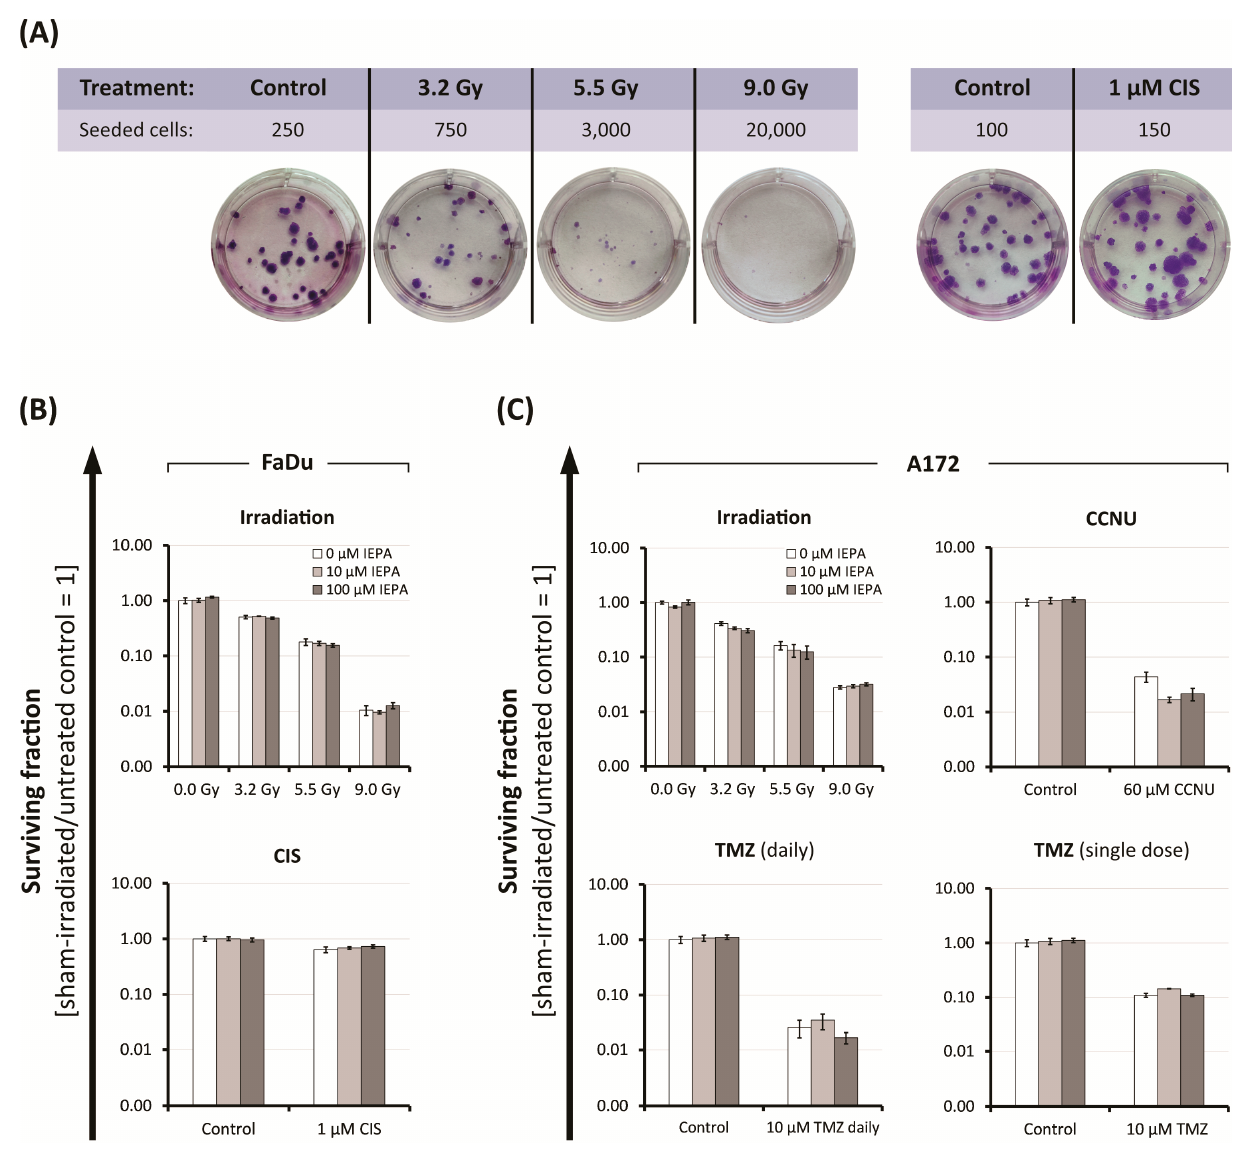
Figure 4. ( A ) Representative images of FaDu colonies, grown in a 6-well plate for clonogenic assay after IR and CIS treatment, stained with Giemsa. Colonies were scored 14-16 days after start of treatment. Clonogenic survival after treatment with IEPA of ( B ) FaDu cells irradiated or treated with CIS, and of ( C ) A172 cells irradiated or treated with CCNU, TMZ daily, or TMZ single-dose. Surviving fractions from one representative experiment conducted in three cell densities, each in duplicates, are presented as mean ±